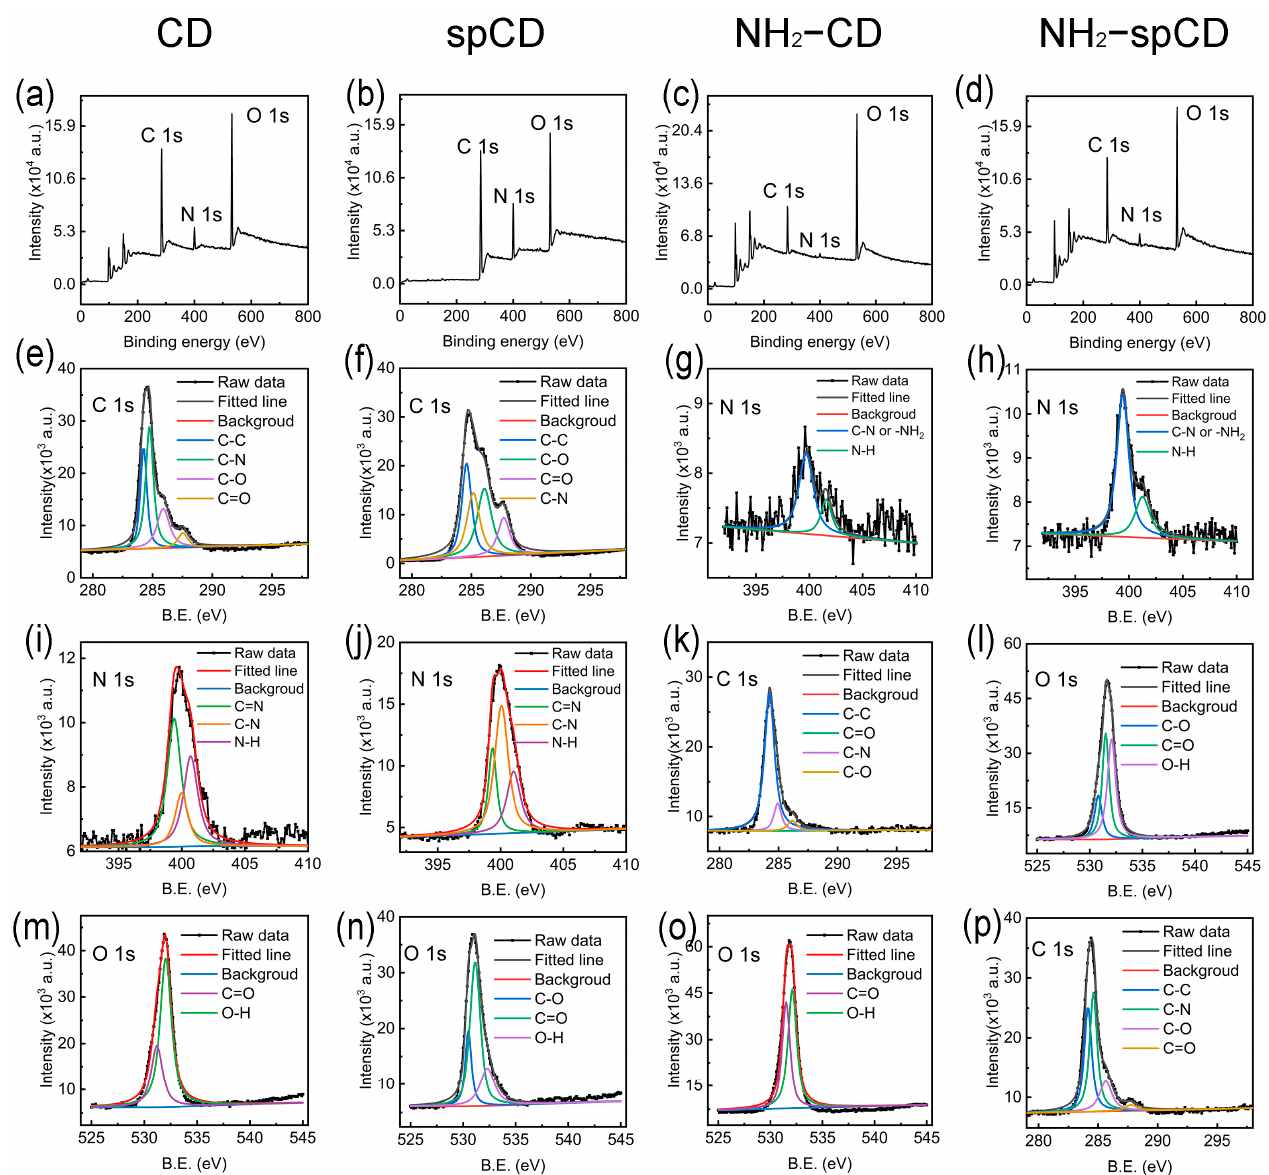
Figure 4. XPS spectra of ( a ) CD, ( b ) spCD, ( c ) NH 2 –CD and ( d ) NH 2 –spCD; High-resolution XPS spectra of C1s for ( e ) CD, ( f ) spCD, ( g ) NH 2 –CD and ( h ) NH 2 –spCD; High-resolution XPS spectra of